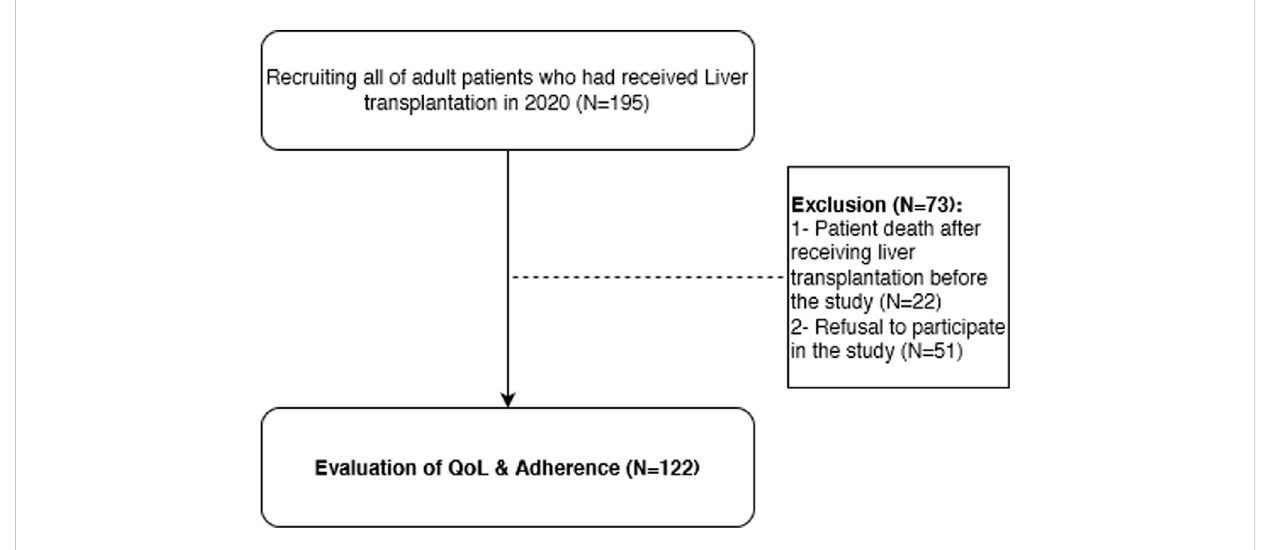
FIGURE 1 Patient enrolmentin and follow up during the study (N =